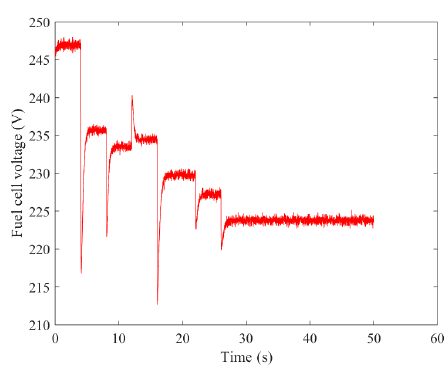
Figure 4. Fuel cell voltage changes with time.